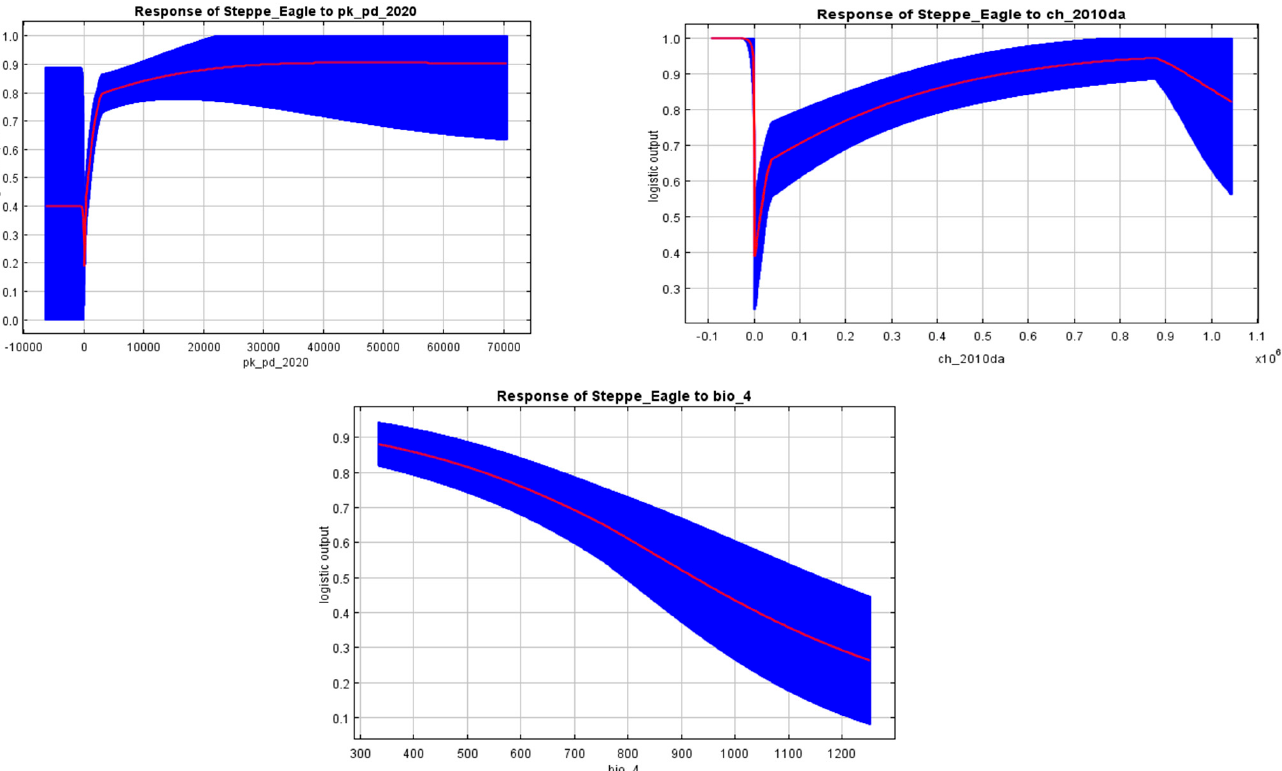
Figure 2. Steppe eagles habitat selection response curves for highly contributing variables. Response curves of predictors for steppe eagle occurrence in Pakistan. Note: The red curves show the mean response of the ten replicate MaxEnt runs, while the mean +/ − one standard deviation is indicated by blue (two shades for categorical variables). The predicted value of habitat suitability (logistic output) is shown on the Y-axis, while the range of the environmental predictors is shown on the X-axis. Results of the jackknife test showed that the environmental variable with the highest gain, when used in isolation, is human population density, which therefore appears to most when omitted is human population density, which therefore appears to have the most information that is not present in the other variables. The values shown are averages over replicate runs (Figure